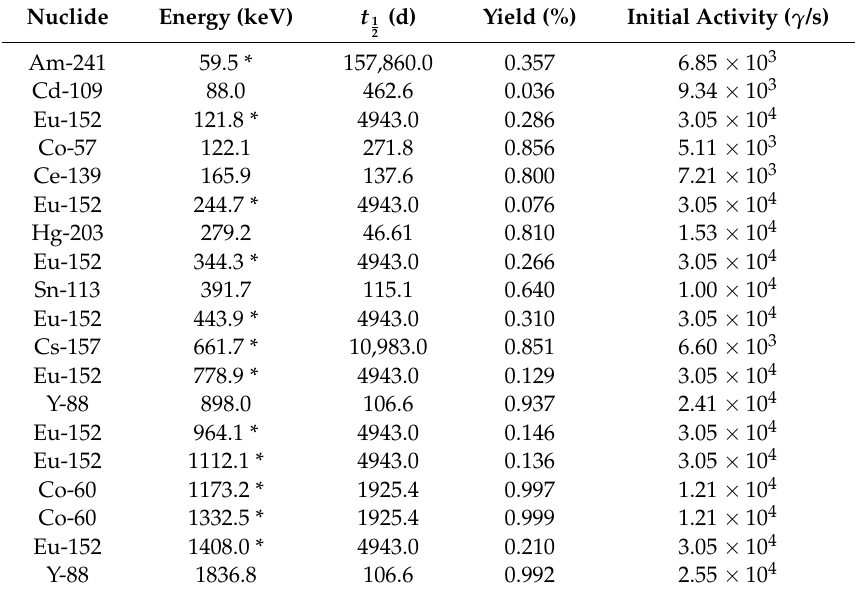
Table 3. Characteristics of the peaks emitted by the Eu-152 and radionuclide mix calibration sources. In total, 12 peaks, marked with a “*” next to the peak energy, were considered for calibration.